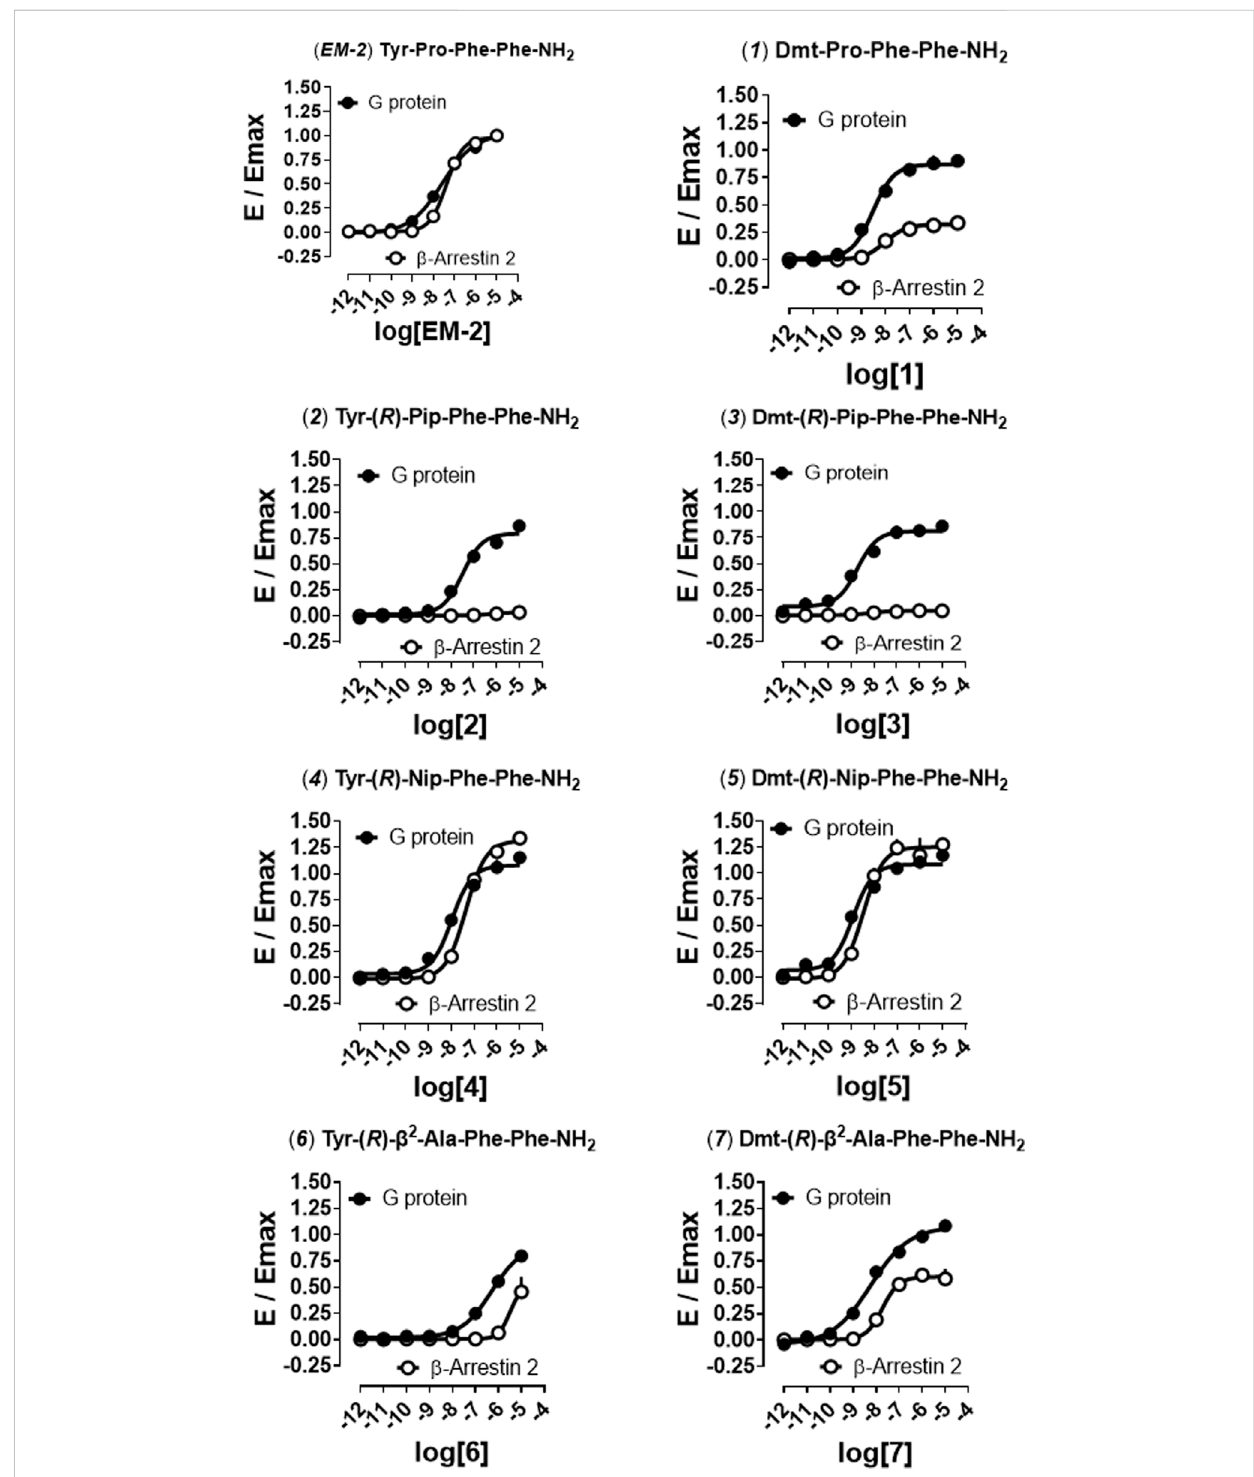
FIGURE 2 Mu receptor-transducer interactions ( EM-2, 1, 2 – 7 ). Effects of EM-2, 2 , 4 , 6 , and corresponding Dmt 1 derivatives ( 1 , 3 , 5 , 7 )in mu -G protein and - β - arrestin 2 BRET interaction assays. Data are mean + SEM of at least four independent experiments performed in duplicate. Corresponding bias plots are reported in Supplementary Figure